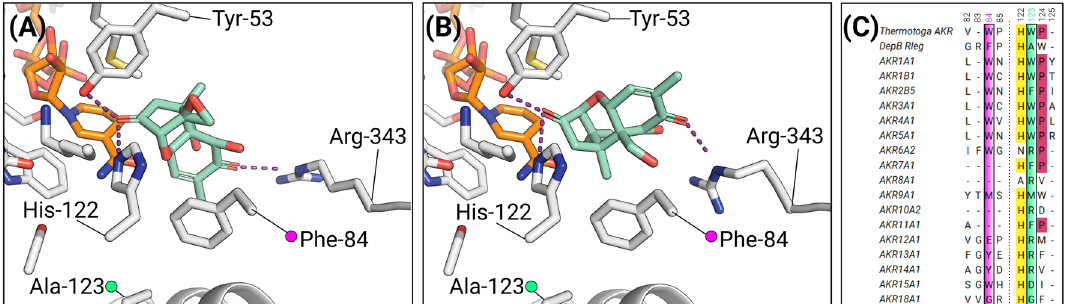
Figure 5. Model of the ternary complex of DepB Rleg . ( A ) Binding orientation for 3-keto-DON for hydride attack at the re -face. π-stacking interactions between Phe-84 and the cyclohexene ring are shaded yellow. ( B ) Binding orientation for 3-keto-DON for hydride attack at the si -face. ( C ) Multiple sequence alignments depicting the sequence variability at positions corresponding to Phe-84 and Ala-123 in DepB Rleg with that of various AKR family